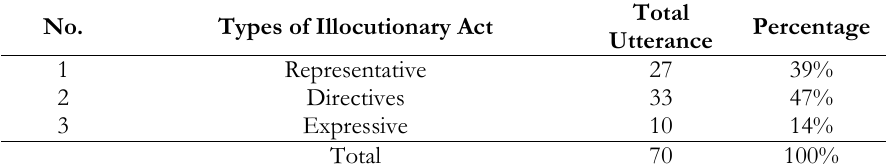
TABLE 6. Percentage types of Illocutionary Act